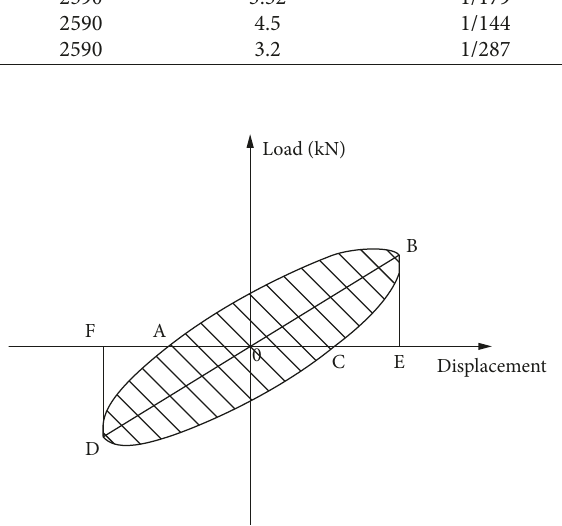
Figure 15: Equivalent viscous damping